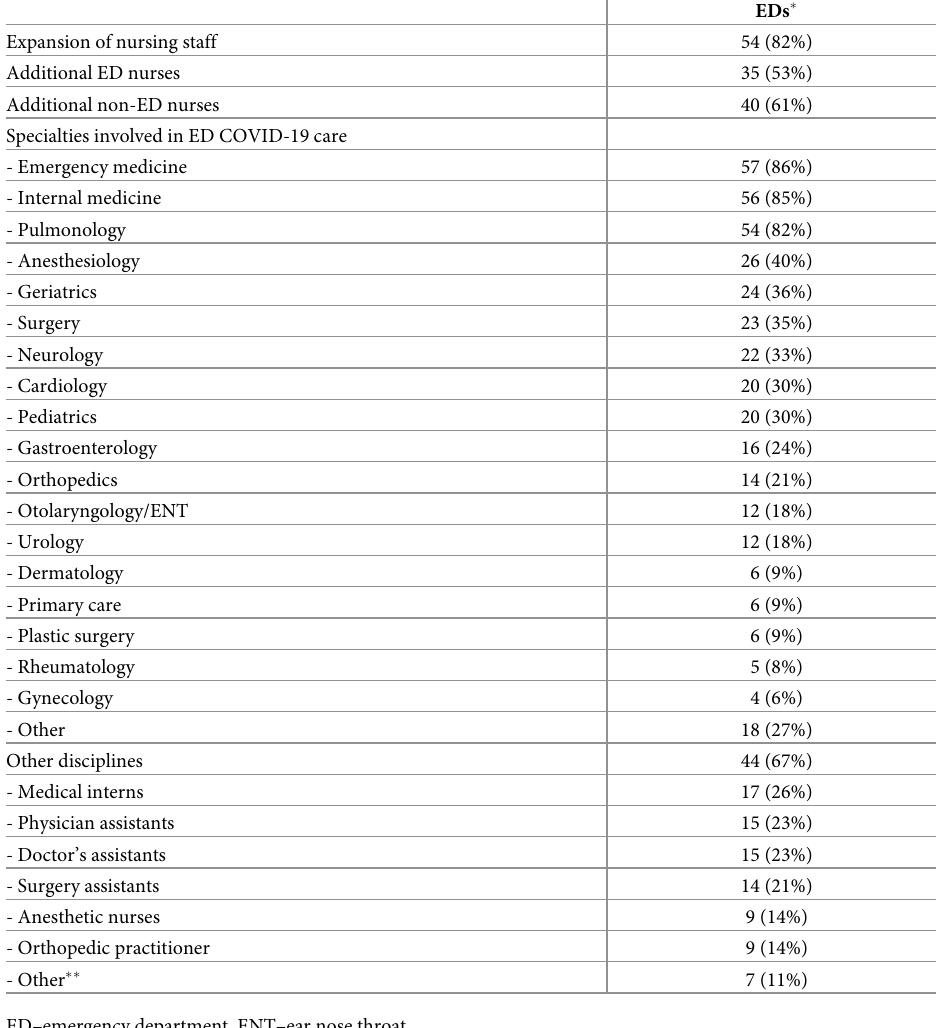
Table 3. Alterations in ED